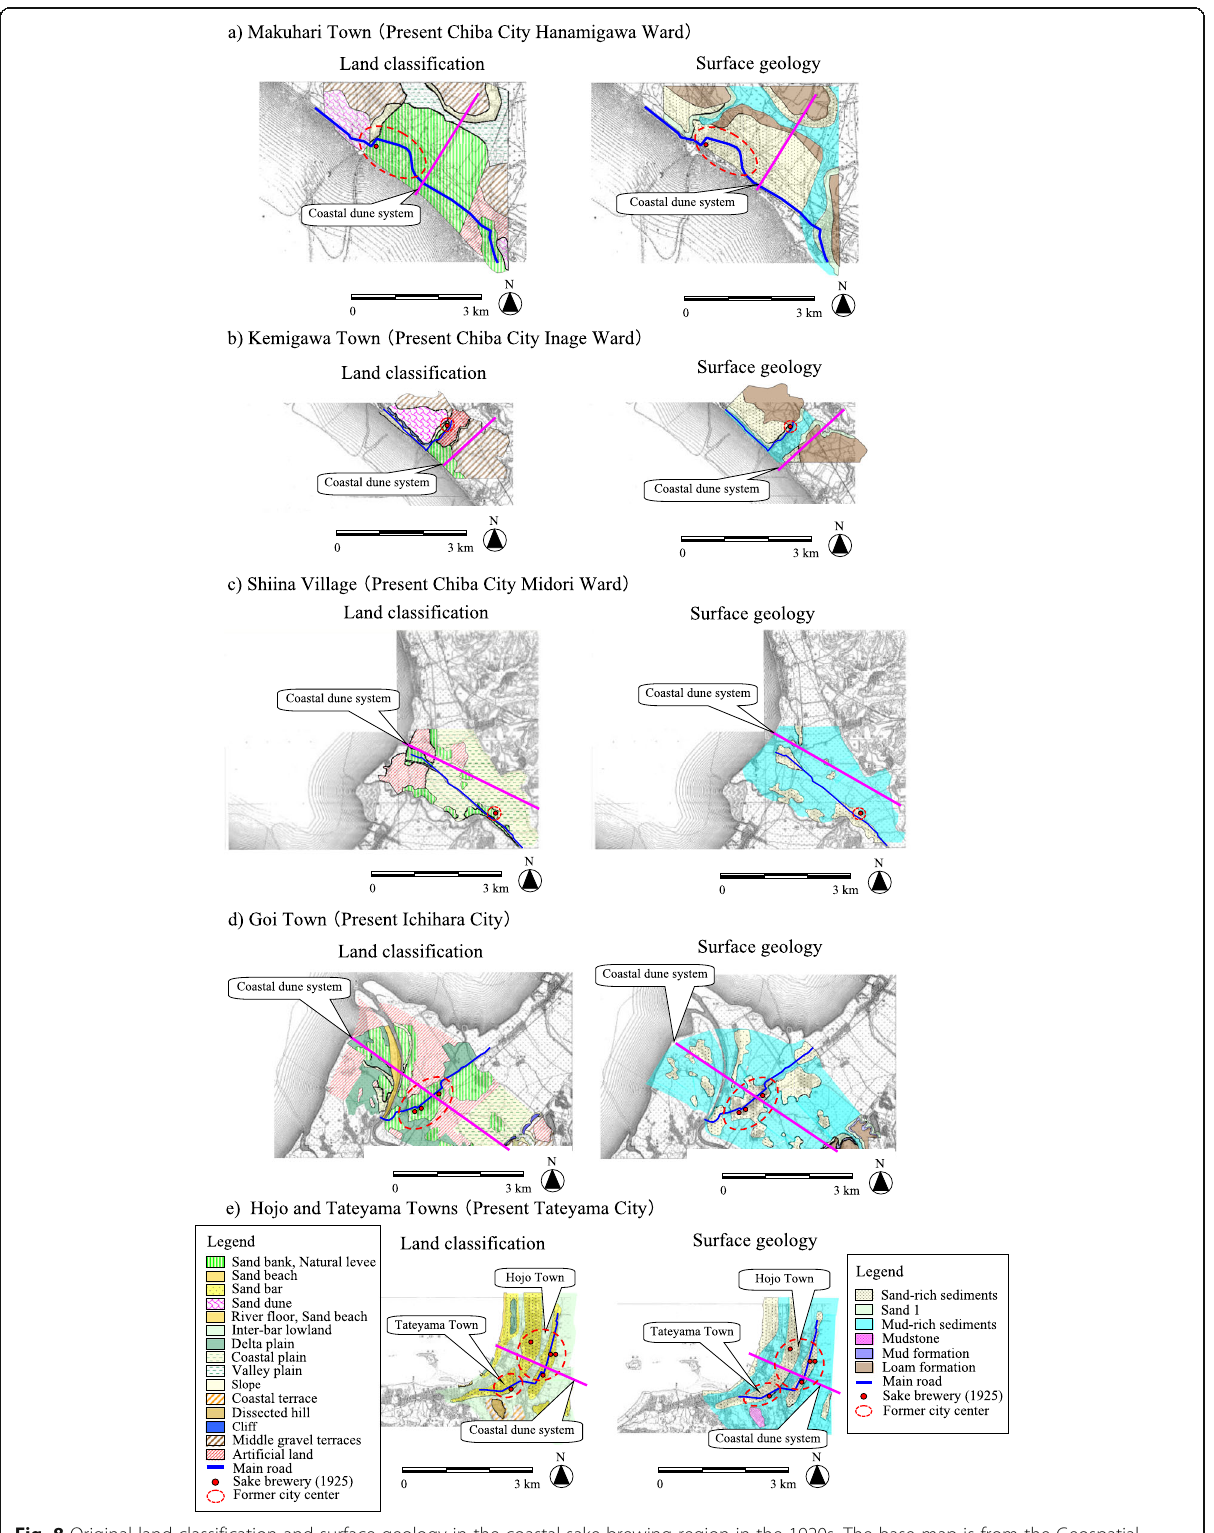
Fig. 8 Original land classification and surface geology in the coastal sake-brewing region in the 1920s. The base map is from the Geospatial Information Authority of